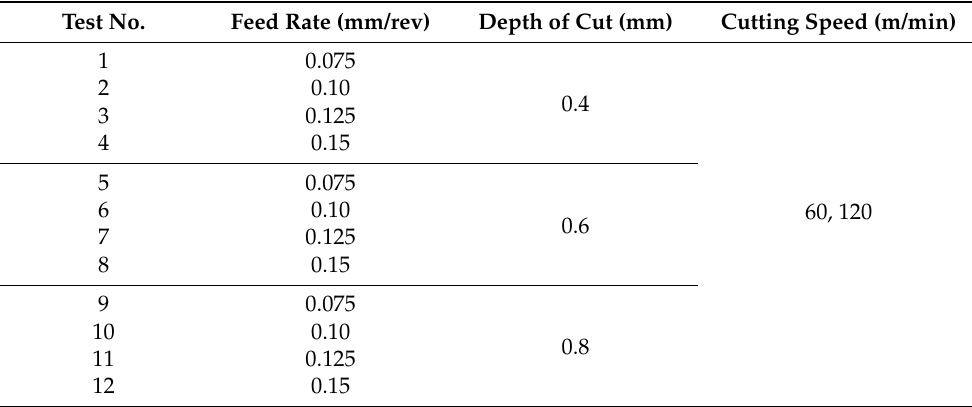
Table 5. The planning of the cutting parameters in the simulations. Test